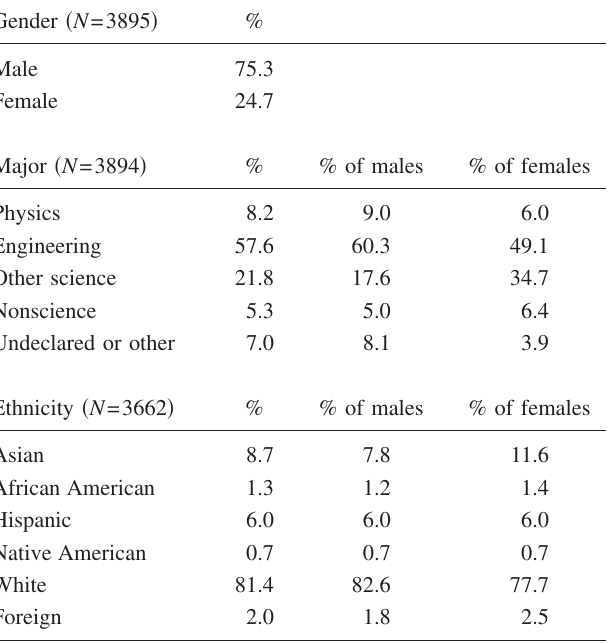
TABLE I. Frequencies for gender, student declared major, and ethnicity for all students in the study, that is, students who enrolled and received a grade in the second-semester introductory physics course between Fall 2004 and Spring